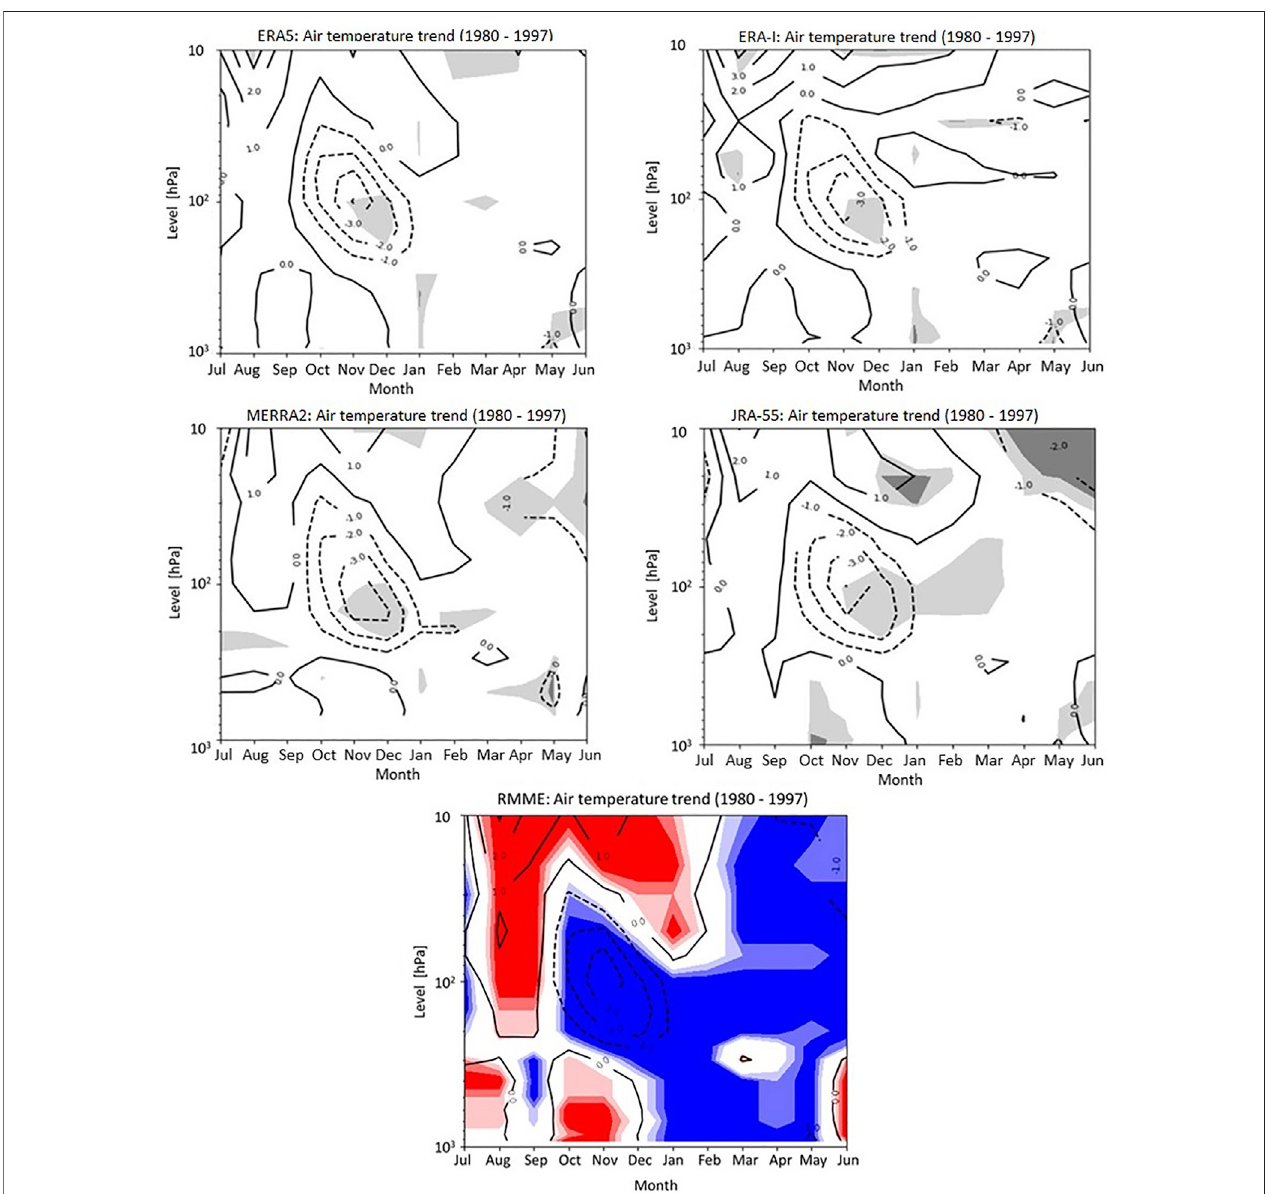
FIGURE 7 | Southern pole temperature trends for the period 1980 – 1997. Contour intervals are 1.0 K/decade. Trends at 95 and 99% con fi dence levels in reanalysesareshaded (lightand darkgrey,respectively).AgreementofsignbetweendatasetsinRMMEarecoloredinblue(red)forcooling(warming)trend,andshades for number of datasets in